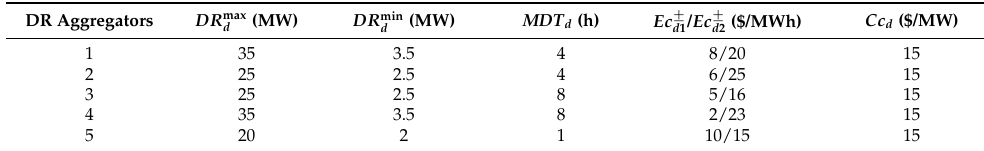
Table 2. DR Aggregator